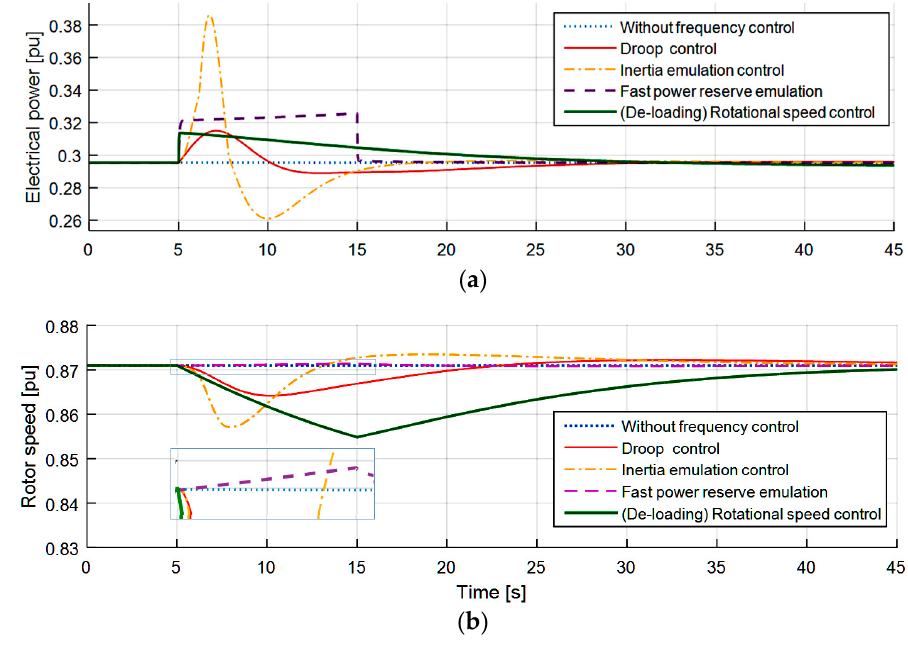
Figure 13. ( a ) Electrical power; and ( b ) rotor speed of VSWT in low wind speed case after frequency disturbance.